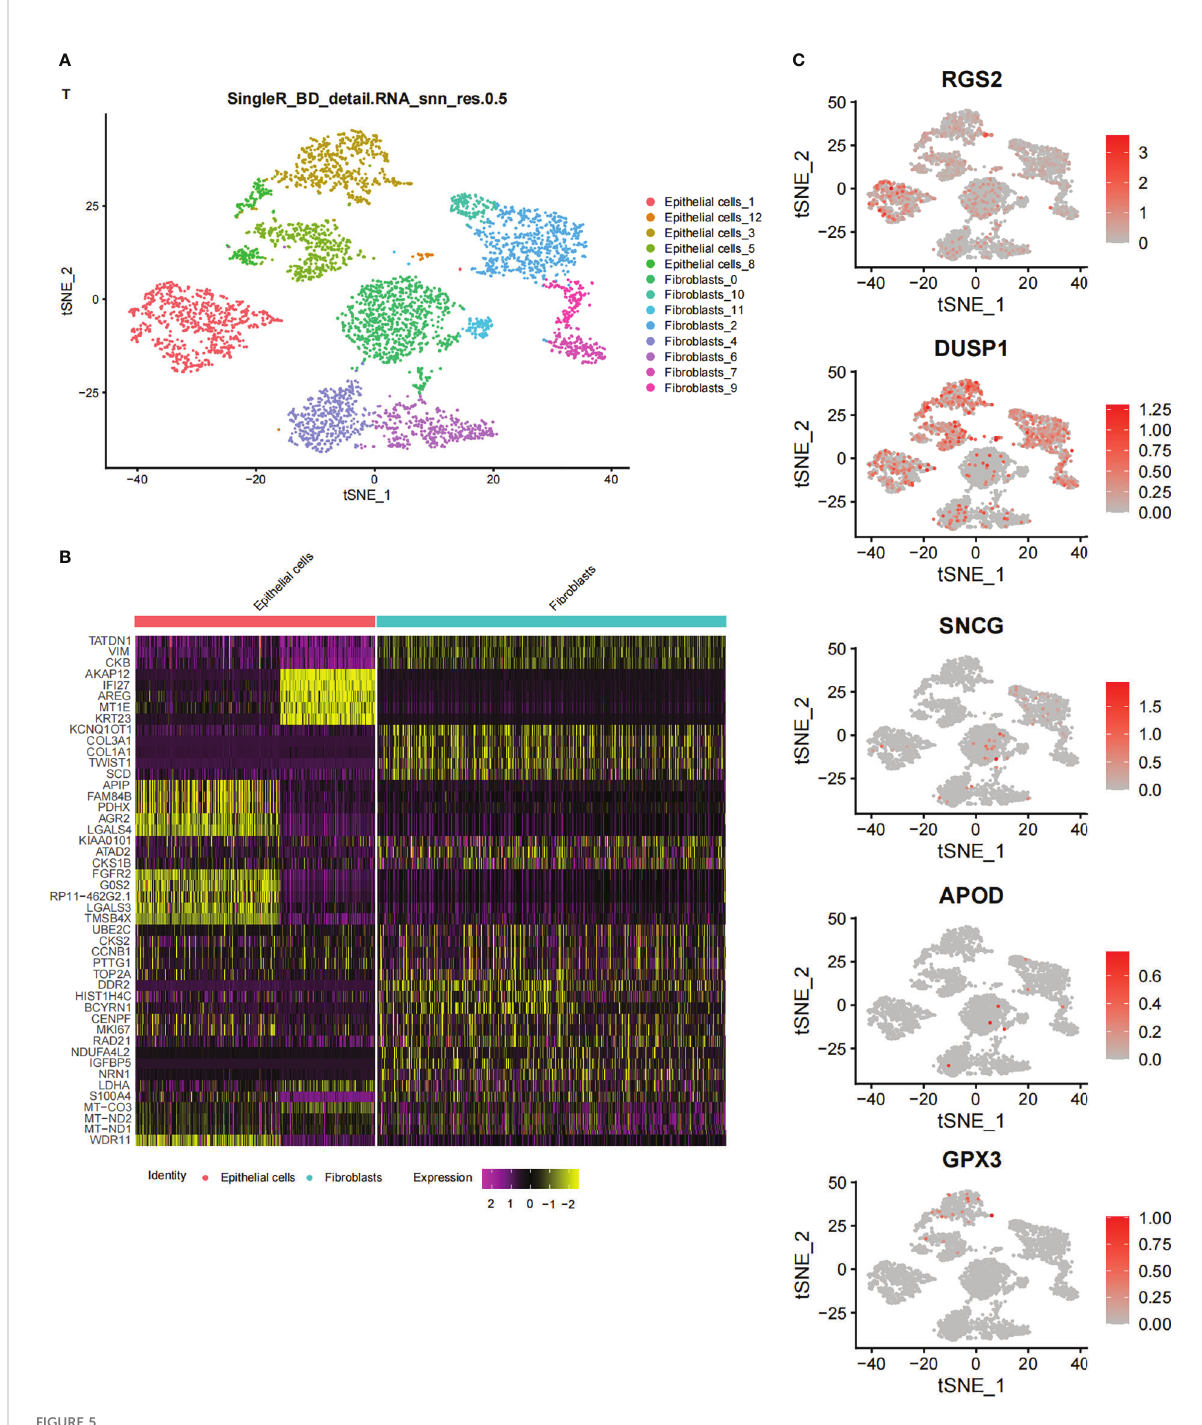
FIGURE 5 Single cell data set analysis (A) T-SNE clustering and cell group annotation based on STAD samples from single-cell data sets. (B) Draw a heat map of the Marker gene of TOP5 in each Cluster. (C) Display the expression and distribution of model genes in the cell population by FeaturePlot